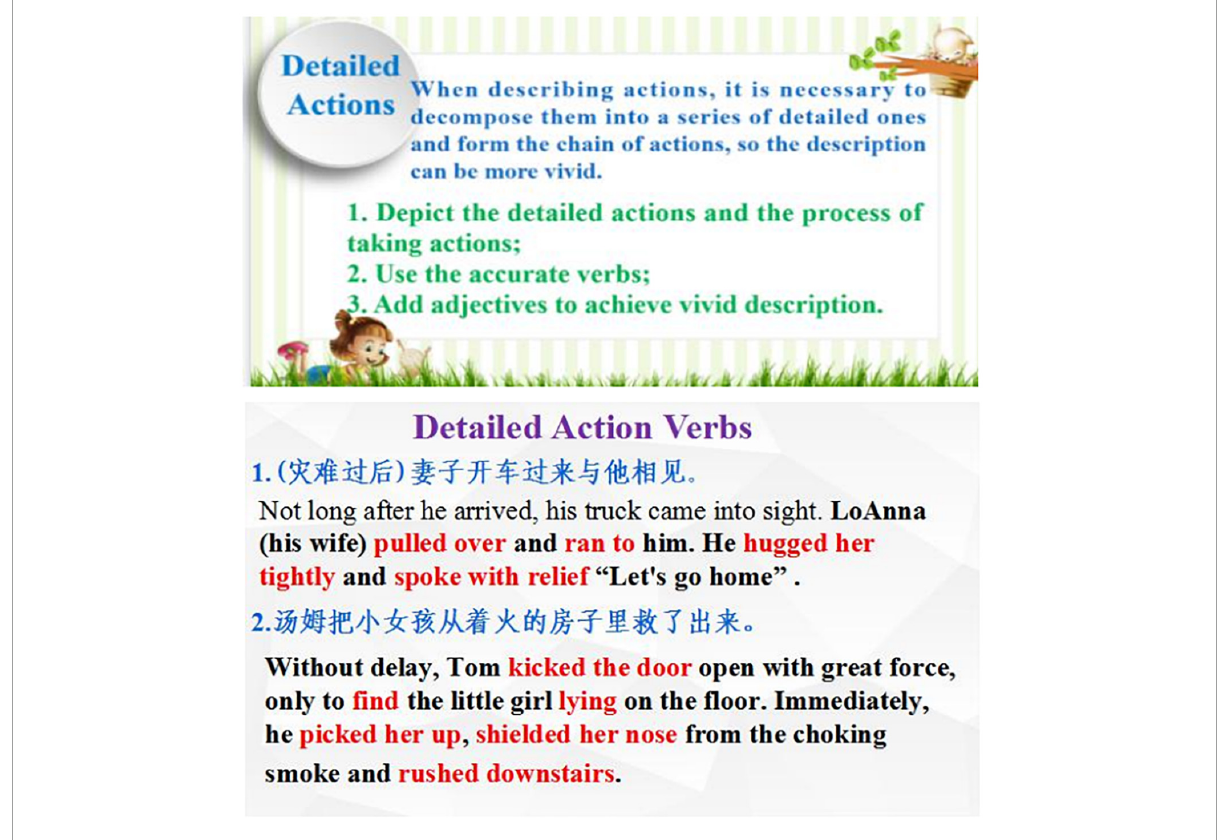
FIGURE3 The teacher-fronted genre analysis (PowerPoint slides from Annie). Reproduced with